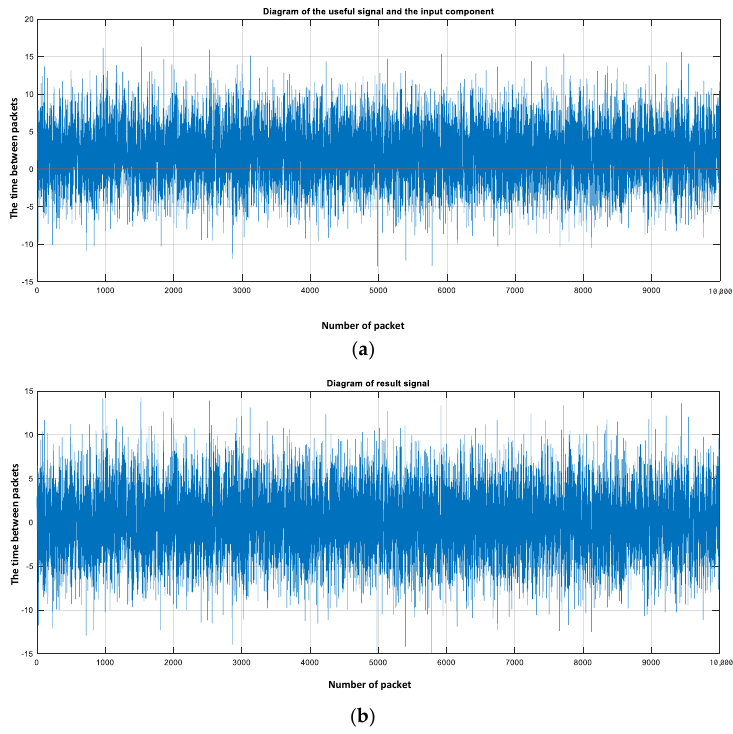
Figure 2. Diagrams of the signals: ( a ) Legitimate traffic (blue color) and illegitimate components (red color); ( b ) Additive mixture.